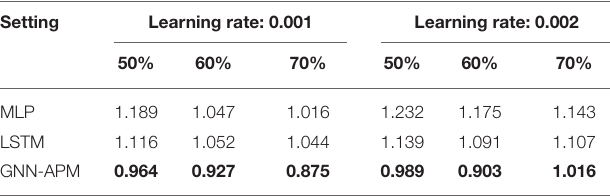
The bold values correspond to results of the proposed GNN-APM method.